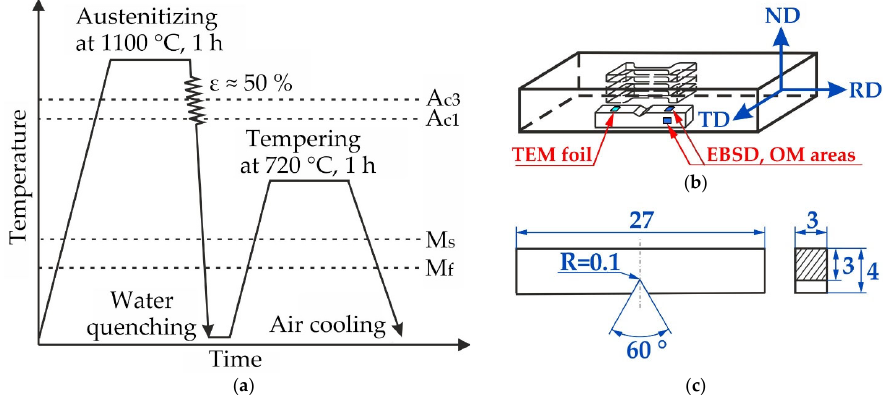
Figure 1. Scheme of high-temperature thermomechanical treatment of steel EK-181 ( a ), scheme of a small (KLST) sample for testing impact strength ( b ), scheme of cutting of the samples after HTMT with respect to the direction and plane of rolling ( c ). Sample dimensions are given in mm. RD is the rolling direction, ND is the direction normal to the rolling plane, TD is the transverse direction. The steel grain ‐ subgrain microstructure, the second phase particle composition and morphology, and the features of their distribution were studied by scanning electron mi ‐ croscopy (SEM) on a Tescan MIRA 3 LMU microscope (TESCAN ORSAY HOLDING, Brno, Czech Republic) with a field emission gun (FEG). It is equipped with a detector of